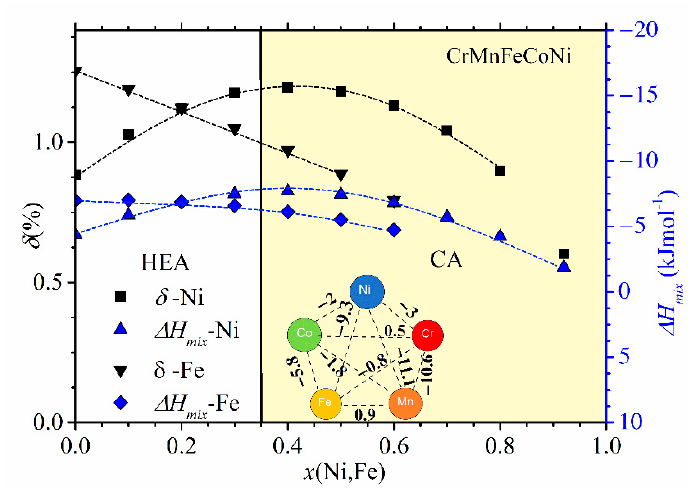
Figure 3. Atomic size mismatch δ and mixing enthalpy ∆ H mix of (CrMnFeCo) 1 − x Ni x and (CrM-